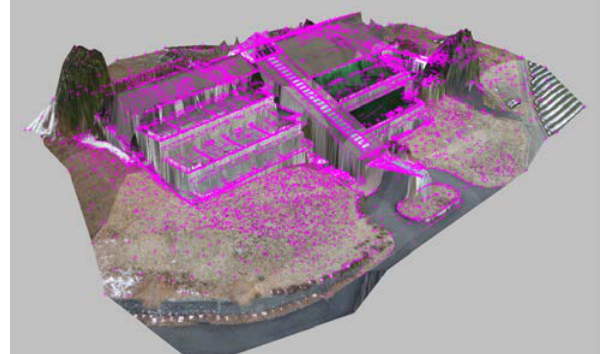
Figure 8. DSM of terrain and buildings